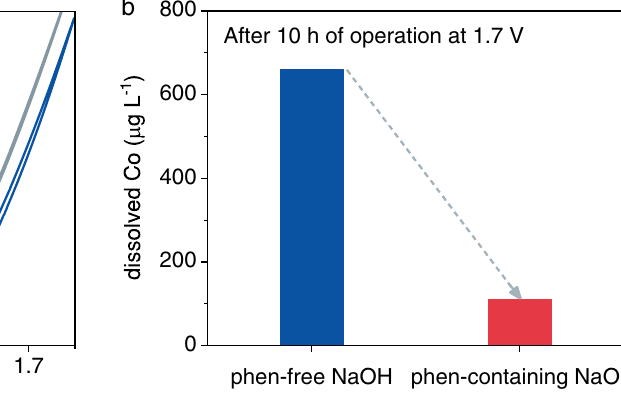
NaOH electrolytes, respectively. b The concentration of Co leached into electro- lytes (measured by ICP-MS after 10h chronoamperometry at 1.7 V RHE